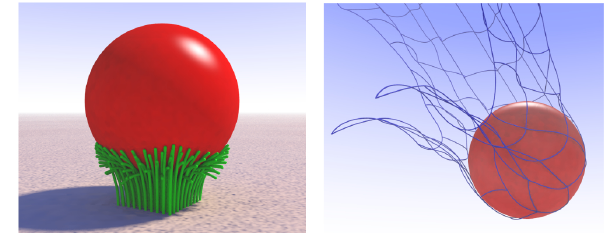
Figure 15. Two models with friction and contact using Chrono ::Flex beam elements: a ball sitting on grass-like beams and a ball hitting a net.